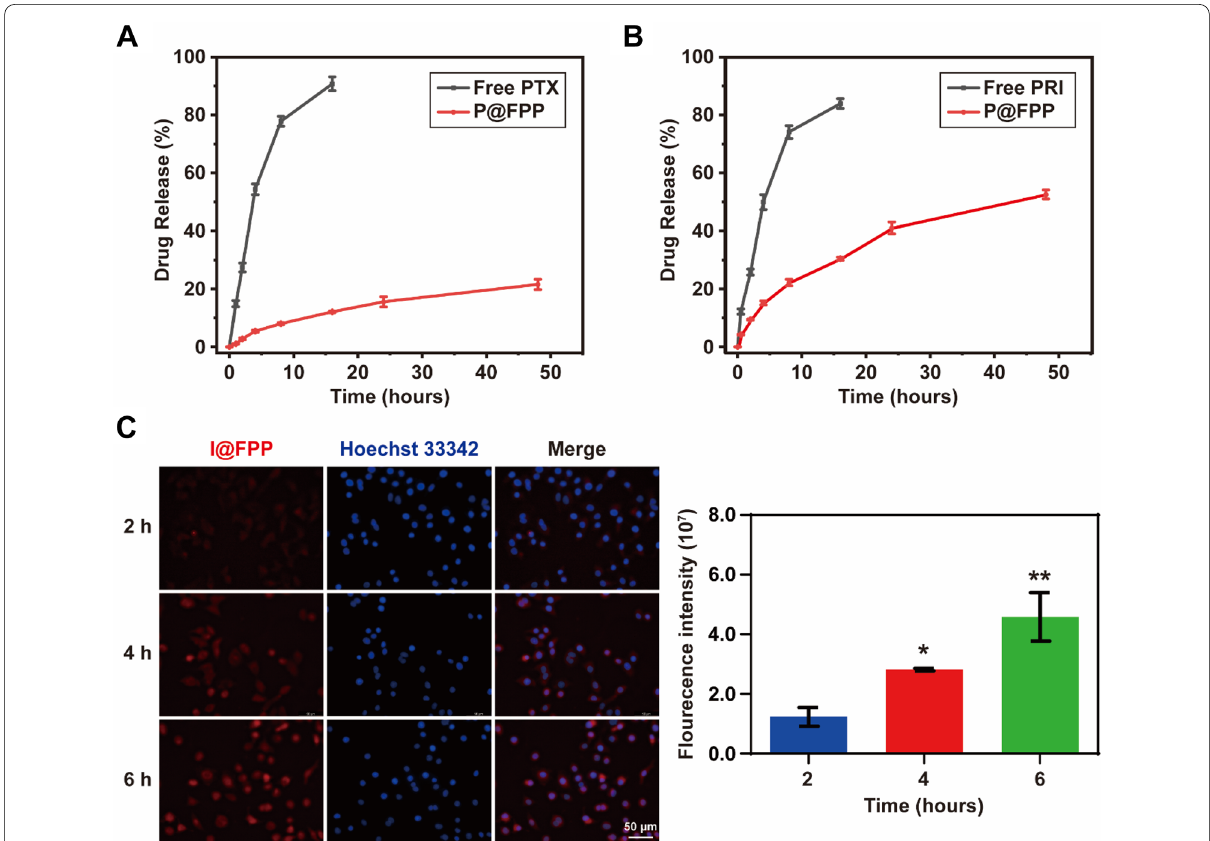
Fig. 4 In-vitro release profiles of drugs from P@FPP NMs. A The release of PTX from P@FPP NMs in phosphate buffered saline (PBS) at different times (pH 7.4). B The drug release of PRI from P@FPP. C Cellular uptake of A549 cells after treated with ICG-loading NMs (I@FPP) for 2, 4, and 6 h = observed by using fluorescence microscope (n 3). Red, ICG; Blue, Hoechst 33,342. Scale bar: 50 μm. *: P < 0.05. **: P < =